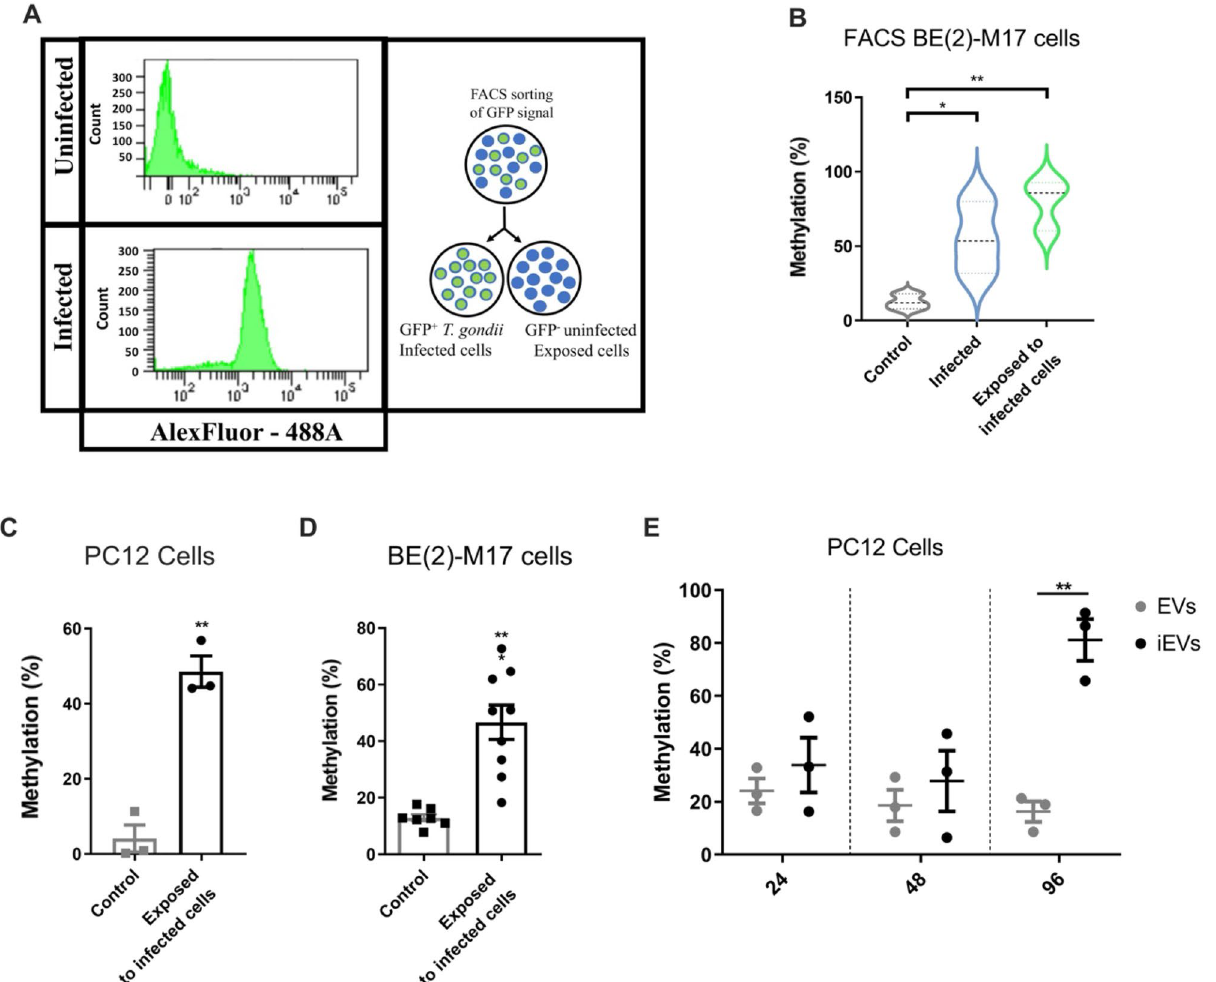
Figure 5. Hypermethylation of the DBH gene promoter region in uninfected, exposed cells. (A) Representative plot showing cell count against GFP signal for FACs of GFP-negative and GFP-positive cells infected with GFP- expressing parasites. Right panel shows a schematic representation of experimental design. (B) Methylation at the 5’ DBH region in uninfected cell culture control and GFP+, and GFP(-) FACS-enriched BE(2)-M17 cells measured using MSRE qPCR; n = 3, * p < 0.05, ** p < 0.01 shown. One-way ANOVA, p = 0.0089, Tukey’s post hoc test exposed to infected cells vs control p = 0.0077. (C) 5 ′ DBH region methylation in PC12 cells exposed to infected PC12 cells in a transwell system as Fig. 2C. ± SEM shown, n = 3, Student’s t test, ** p < 0.01. (D) BE(2)-M17 cell DBH promoter methylation measured as in ( C ) following 5 days transwell exposure to either uninfected (n = 4) or infected BE(2)-M17 cells (n = 9). ± SEM shown, Student’s t test, *** p < 0.001. (E) Time course of methylation changes induced by TINEV treatment. 5’ DBH methylation in cells treated with TINEVs (black) and EVs from uninfected cells (grey). Timepoints taken at 24, 48 and 96 h of treatment; Line indicates mean with 95% CI; n = 3, ** p = cultures and delivered into the brain induced DBH down-regulation in neurons. EVs are continuously released in the brain limiting our ability to detect and isolate those induced by the 0.002–0.14% of cells that are infected during chronic T. gondii infection and restricted by the current lack of biomarkers for TINEVs. The findings presented here provide a mechanism that can resolve the enigma of an observable decrease in NE when only a